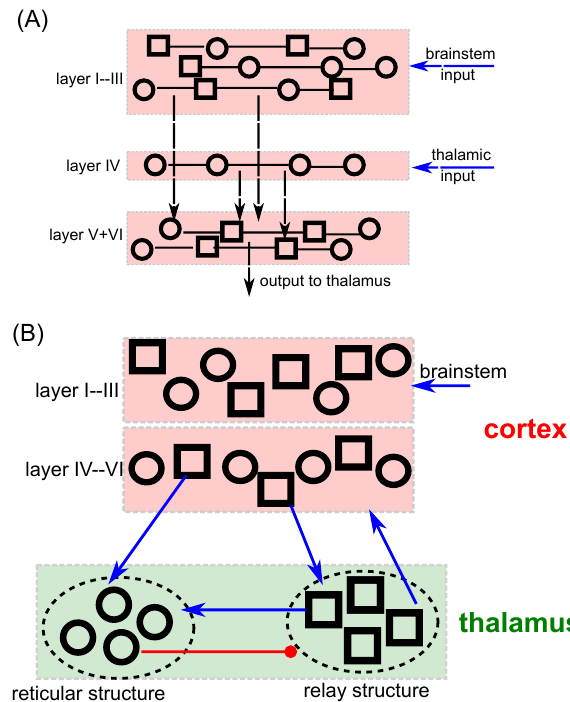
Figure 1. Cortico-thalamo-cortical network model of neural populations. ( A ) The supragranular layers I–III, granular layer IV and infragranular layers V and VI exhibit excitatory (represented by squares) and inhibitory (circles) neurons. ( B ) Blue and red connections between cortex and thalamic structures denote excitatory and inhibitory synaptic connections. The reticular and relay structures includes inhibitory (circles) and excitatory (squares) neurons,